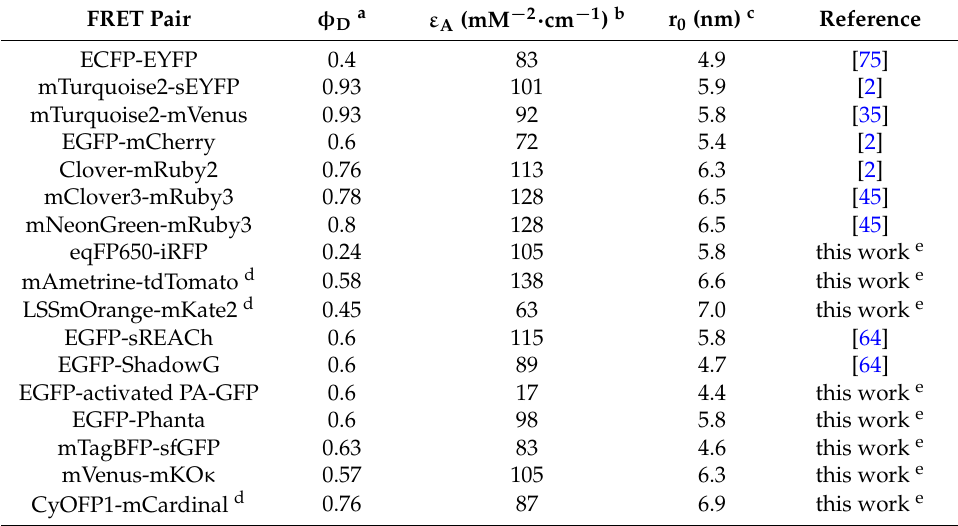
Table 3. List of commonly used and large-r 0 FP-based FRET